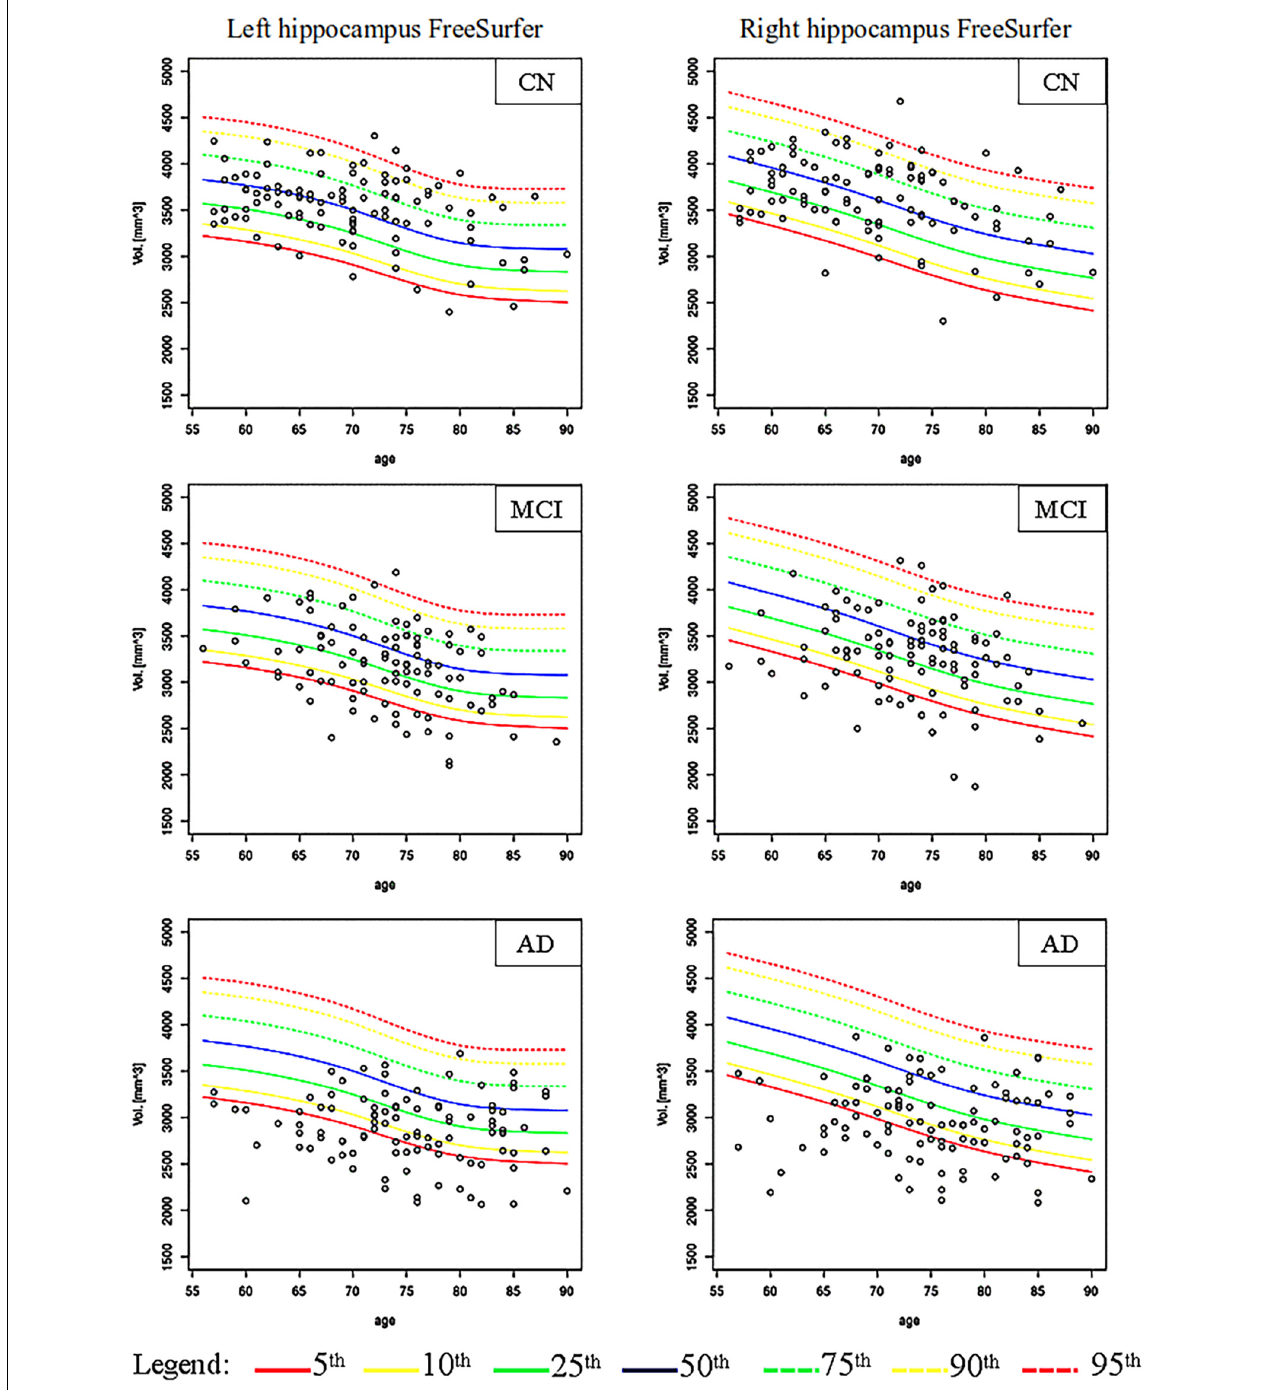
FIGURE 2 | Age-specific percentile distribution of ARWiBo hippocampal volumes processed with FS. Left and right scatter plots of ARWiBo hippocampal volumes (mm 3 ) (100 CN, 100 MCI, 100 AD) from 56 to 90 years on the ADNI percentiles chart. CN, cognitively intact healthy Control; MCI, Mild Cognitive Impairment; AD, Alzheimer’s